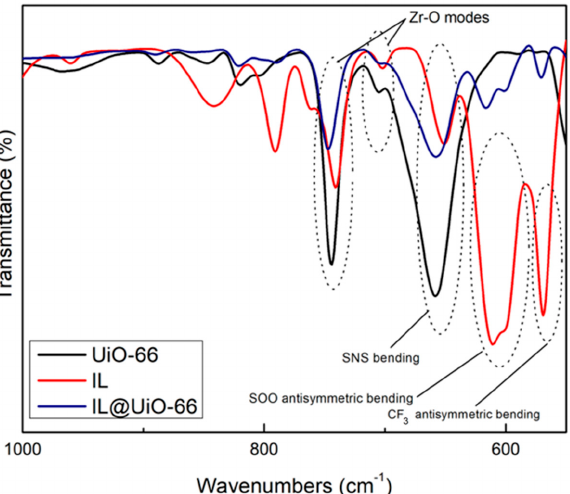
Figure 12. FTIR spectrum of UiO-66, IL and IL@UiO-66 from 1000 to 550 cm − 1 .